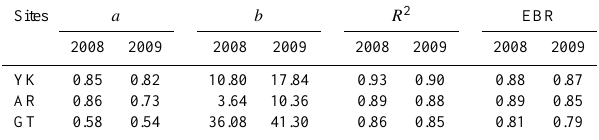
Table 2. Coefficients of the relationship between H + LE and R n − G 0 , and the EBR at the three sites in 2008 and